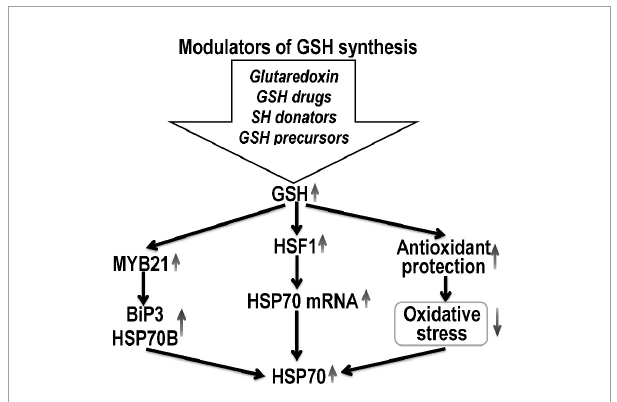
FIGURE2 Hypothetical mechanism of HSP70 expression regulation by pharmacological glutathione modulators. Glutathione promotes HSF1 nuclear translocation and enhances the expression of